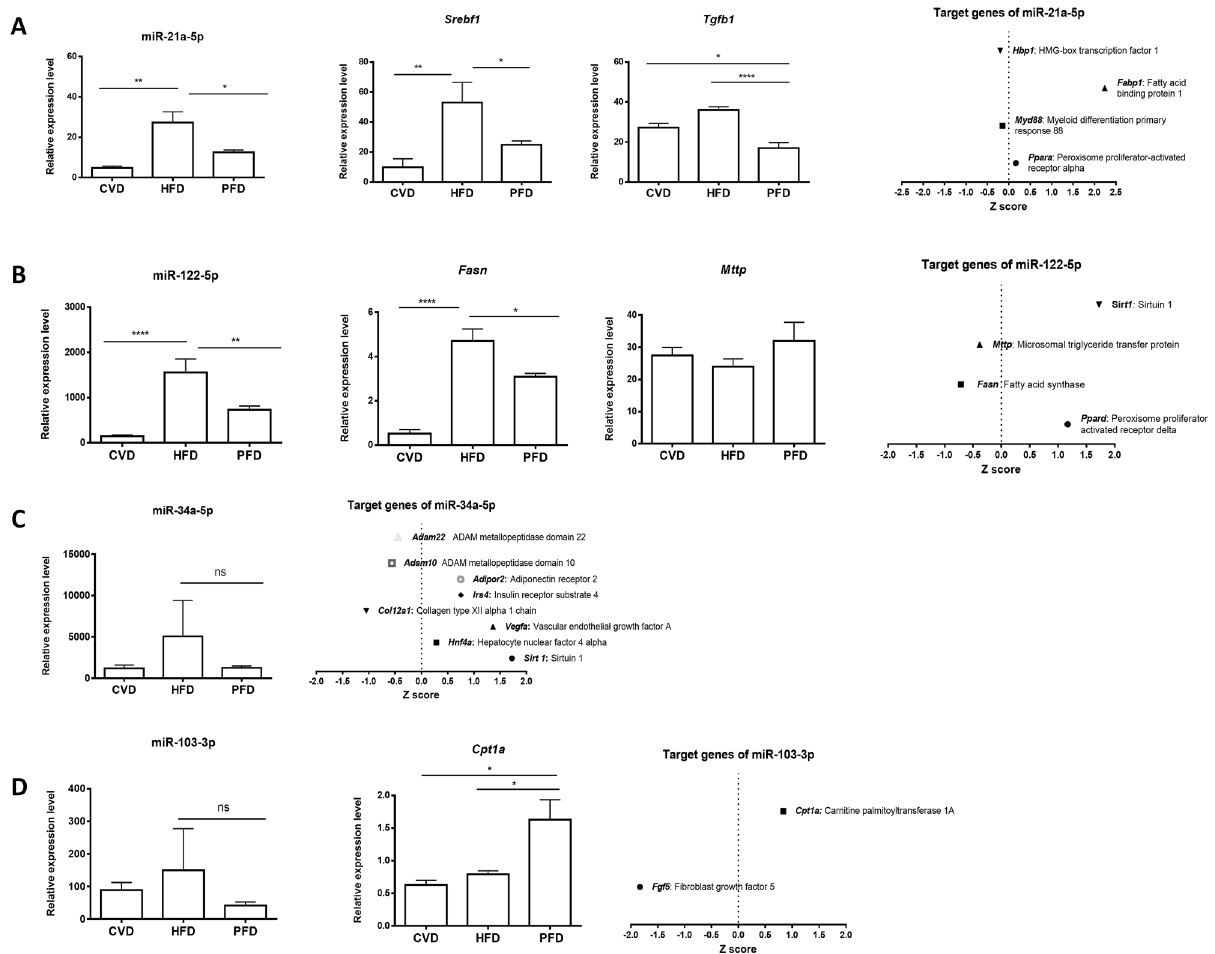
Figure 1. Hepatic expression of selected miRNAs involved in the pathogenesis of non-alcoholic steatohepatitis and their target genes. ( A ) miR-21a 5p, Srebf1 and Tgfb1 gene expression by qPCR. Final panel presents microarray analysis for several miR-21a 5p target genes. ( B ) Expression analysis of miR-122-5p and mRNA levels of Fasn and Mttp ; and microarray of miR-122-5p target genes. ( C ) miR-34a-5p gene expression and microarray analysis of targeted genes. ( D ) Levels of miR-103-3p and Cpt1a by qPCR, and microarray analysis of miR-103-3p targeted genes. CVD conventional diet, HFD high fat and high carbohydrate diet, PFD high fat and high carbohydrate diet + prolonged-release pirfenidone. *p < 0.05, **p < 0.01, ****p <